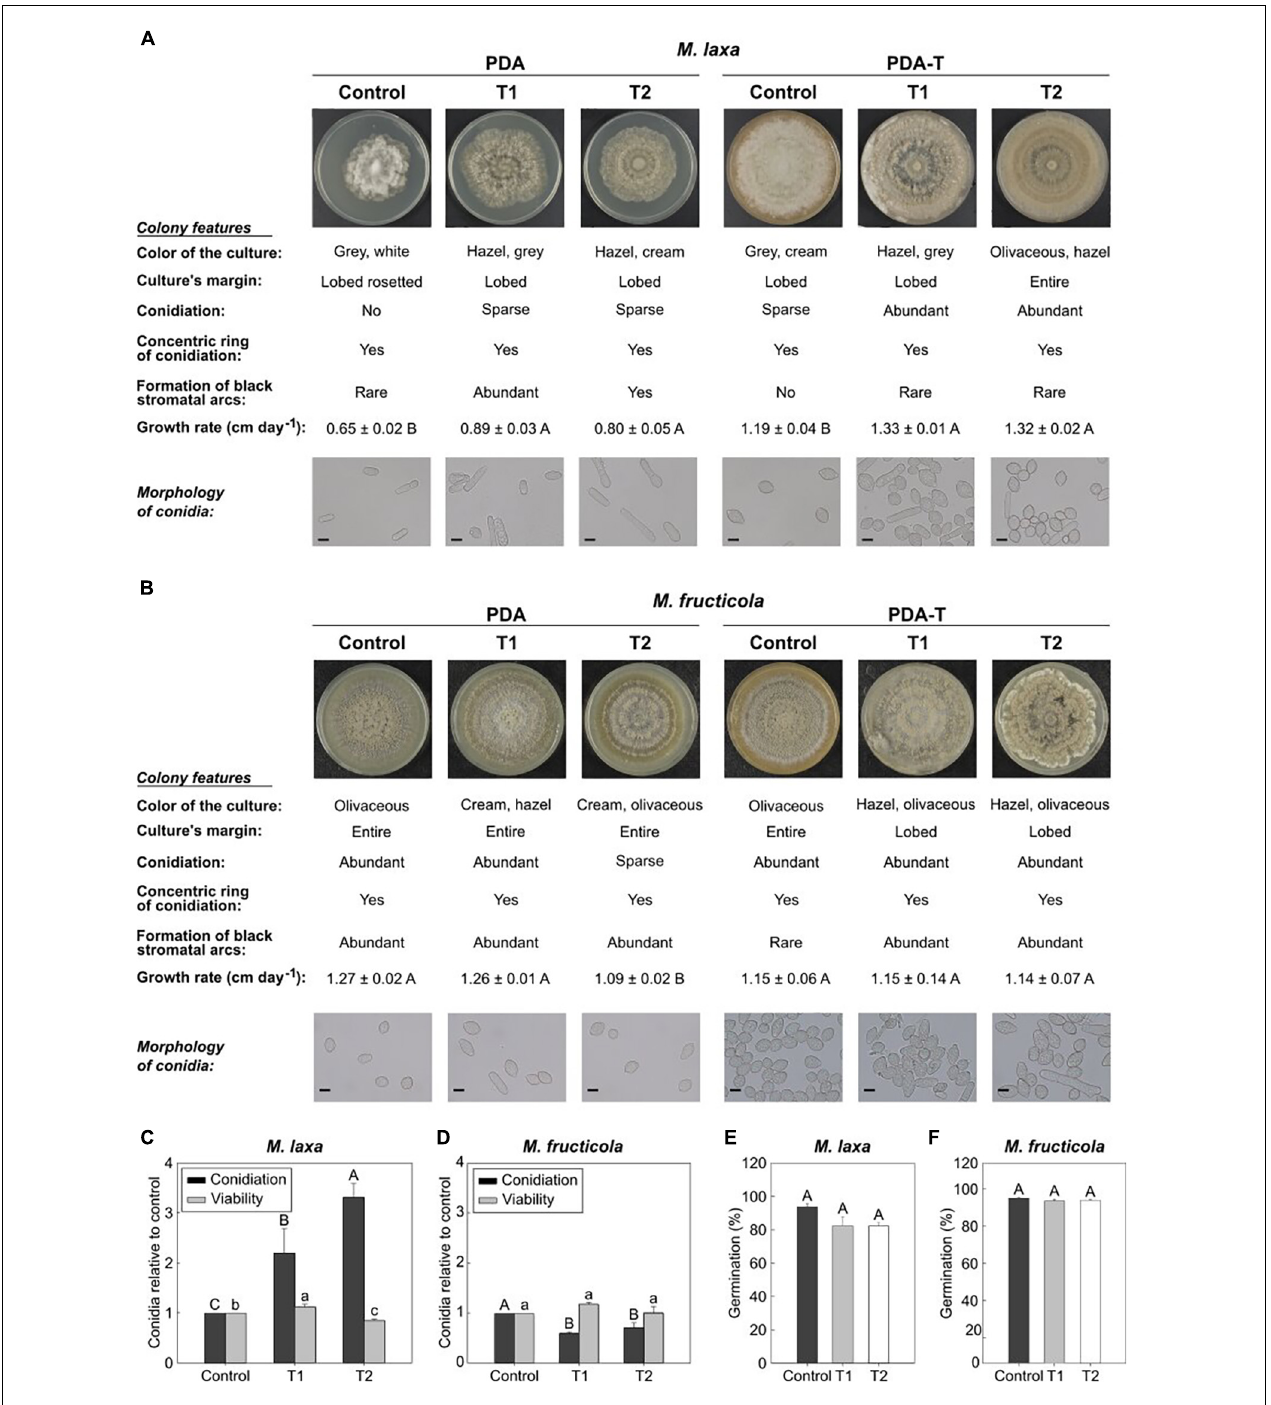
FIGURE 1 | In vitro ecophysiology of Monilinia spp. after exposure to treatments 1 and 2 and control condition (constant darkness). Images of Monilinia cultures, description of colony features, growth rate (cm day − 1 ) and microscopy images (40 × ) of M. laxa (A) and M. fructicola (B) grown on PDA and PDA-T and incubated under each light condition. Data for growth rate represent the mean of replicates ( n = at least 4) ± standard error of the means. Different letters indicate significant differences ( P ≤ 0.05) among incubation conditions according to orthogonal contrasts. Scale bar for microscopy images is indicated (10 µ m). Conidiation and conidial viability of M. laxa (C) and M. fructicola (D) grown on PDA-T incubated under each light condition. Data is represented relative to the control condition (control = 1). Different uppercase and lowercase letters indicate significant differences ( P ≤ 0.05) of conidiation and conidial viability, respectively, among incubation conditions according to orthogonal contrasts. Germination (%) after 6 h of M. laxa (E) and M. fructicola (F) on PDA medium. Different letters indicate significant differences ( P ≤ 0.05) among incubation conditions according to orthogonal contrasts. For panels (C–F) , bars represent the mean of replicates ( n = at least 4) and error bars represent the standard error of the